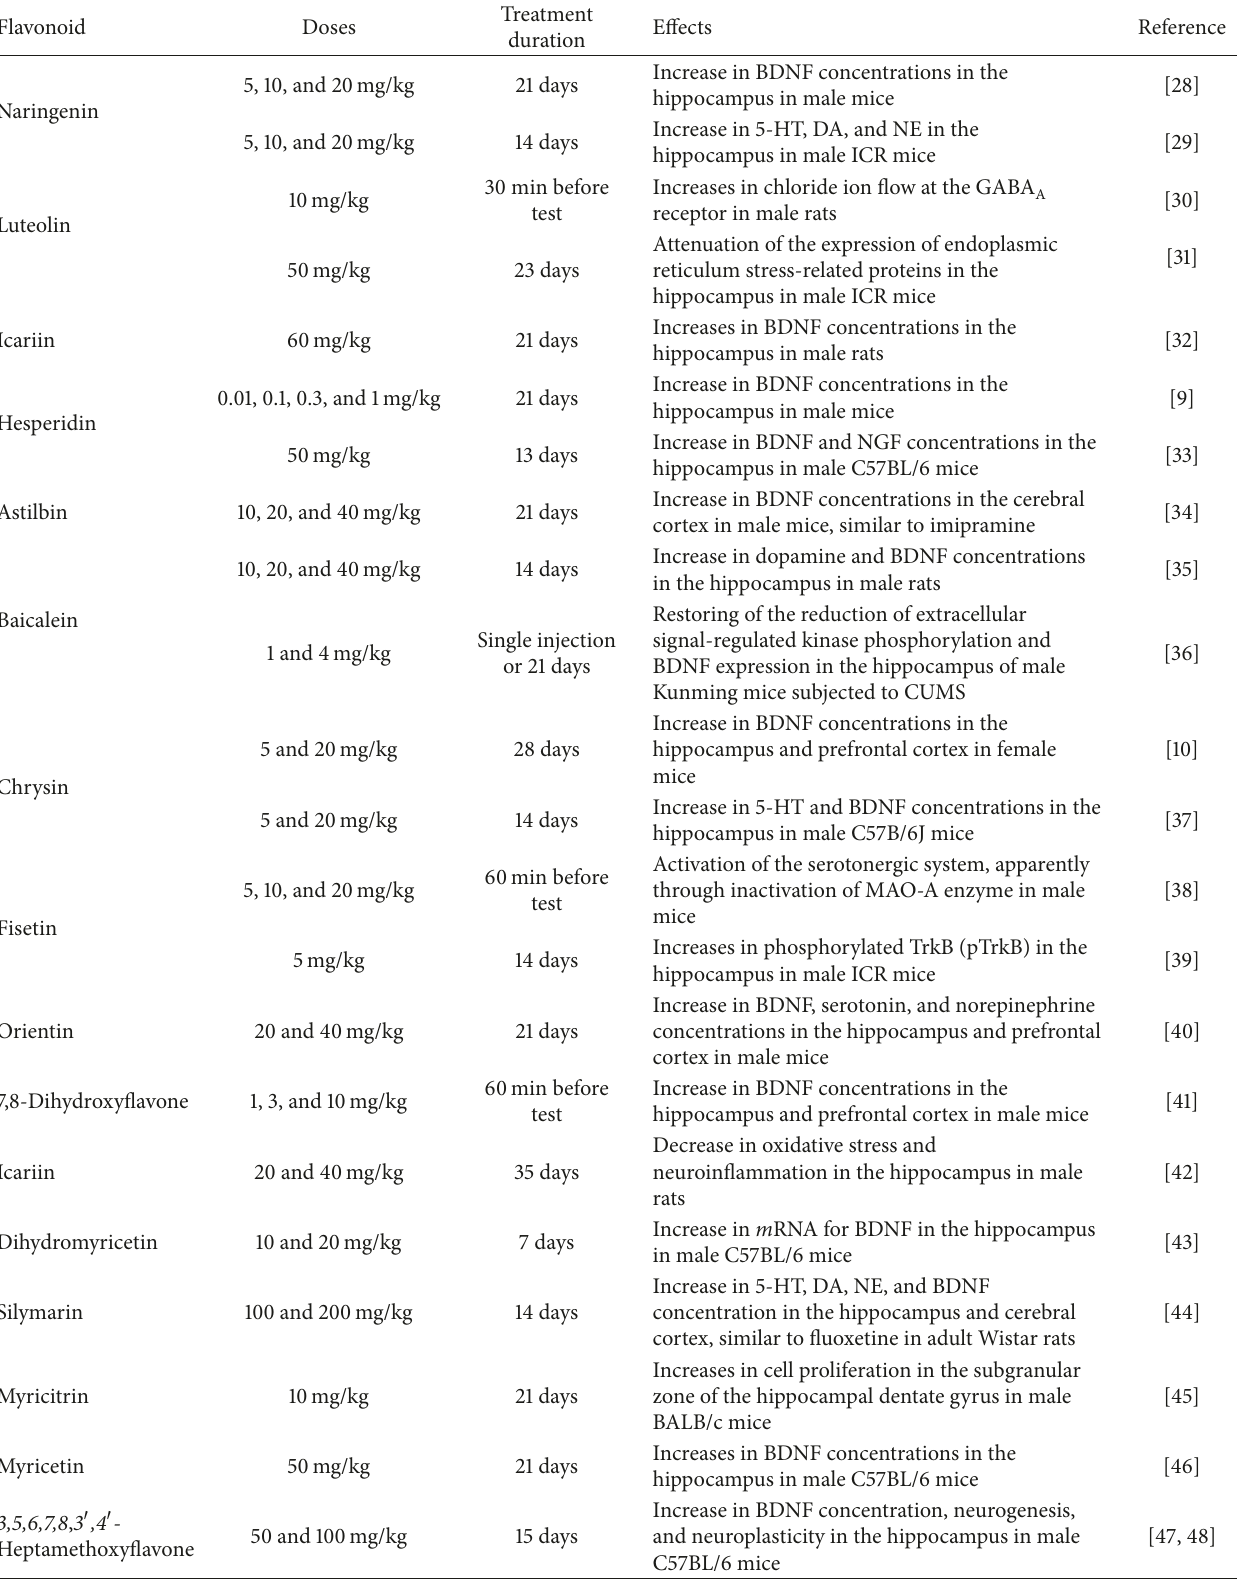
Table 2: Neurobiological effects produced by some